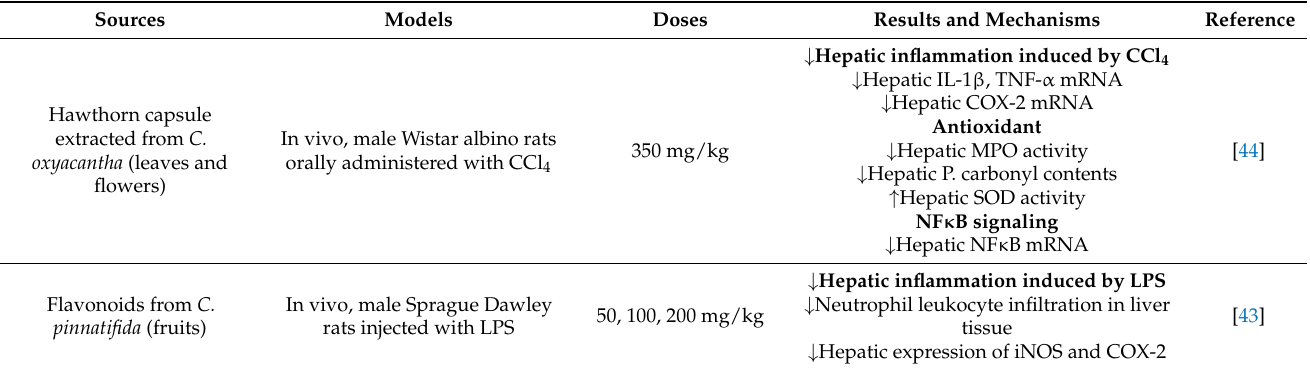
Table 3. Anti-inflammatory and antifibrotic effects and molecular mechanisms of hawthorn